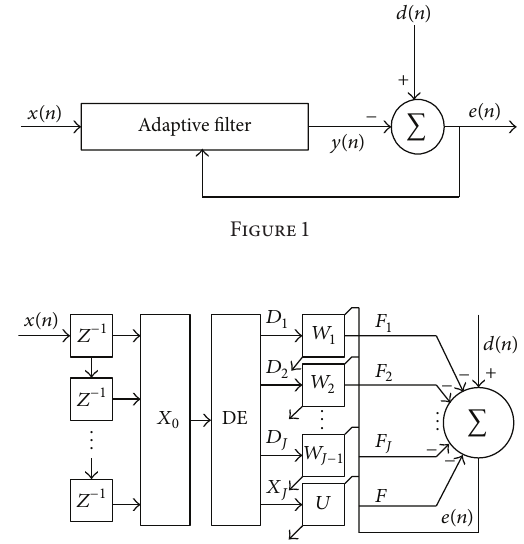
Figure 2: Decomposition LMS